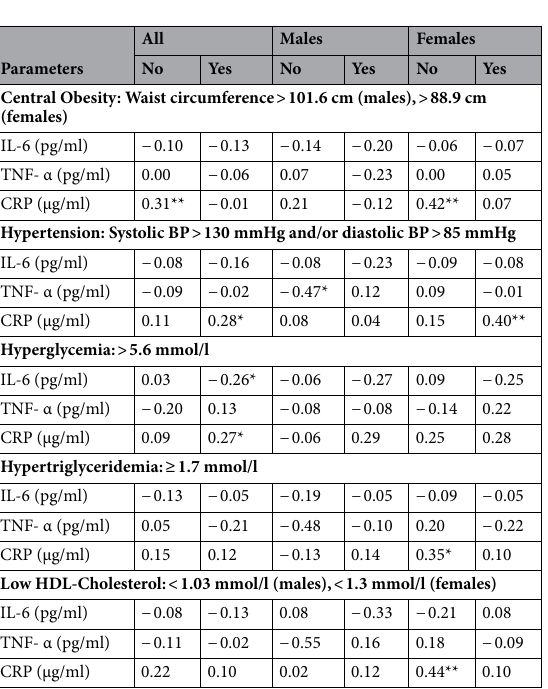
Figure 1. Bivariate associations of ZAG with Cardiometabolic Parameters.